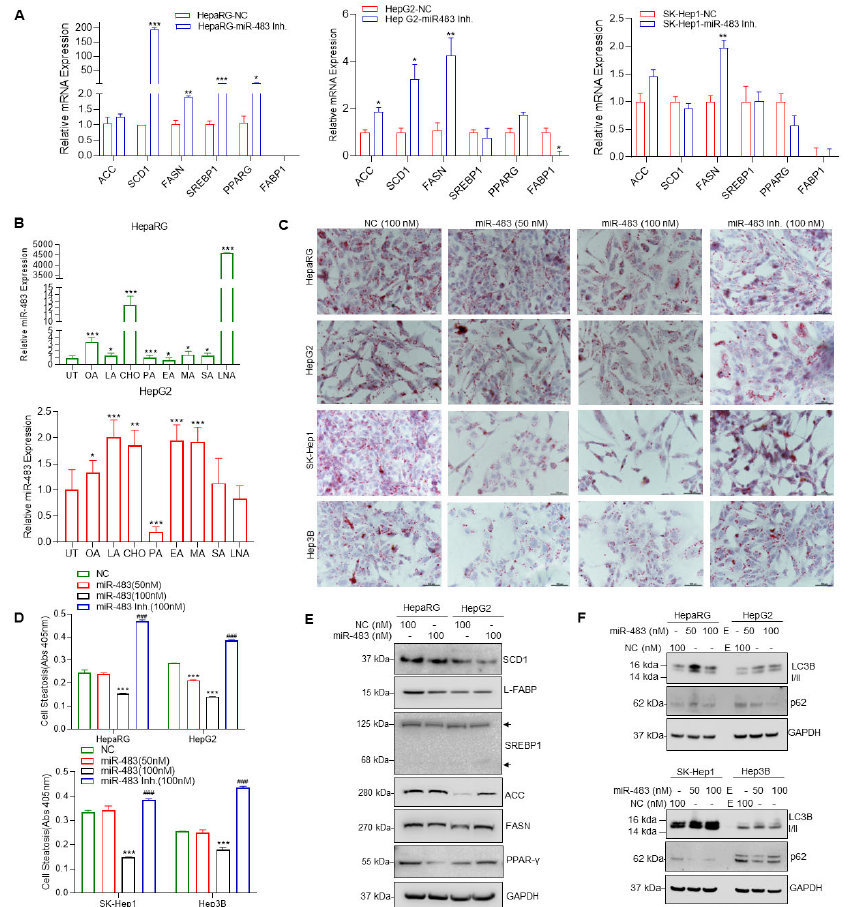
Figure 4. ( A ) HepG2 and SK-Hep1 cells were transfected with NC (100 nM) or miR-483 inhibitor (100 nM) as indicated for 30 h, and the expression of FASN , SREBP1 , ACC , FABP , PPAR γ , and SCD1 were analyzed RT/qPCR. * p < 0.05, ** p < 0.01, *** p < 0.001 compared to NC transfected cells. ( B ) HepaRG and HepG2 cells were treated with 100 µ M of indicated fatty acids for 30 h, and the expression miR-483 was analyzed by RT/qPCR. * p < 0.05, ** p < 0.01, *** p < 0.01 compared with untreated cells (upper and lower panels). ( C ) HepaRG and HCC cells were grown on coverslips and transfected with NC (100 nM) or miR-483 mimic (100 nM) or miR-483 inhibitor as indicated for 18 h and treated with oleic acid (100 µ M) for an additional 24 h. Cells were fixed, stained with Oil Red O (ORO), and images were captured using a Nikon Y-IDP microscope. ( D ) HepaRG and HCC cells were grown in 6-well plates in triplicates, transfected with NC, miR-483, and miR-483 inhibitor for 18 h, and then treated with 100 µ M oleic acid for an additional 24h. Cells were fixed and stained with an Oil Red O (ORO), cells were lysed, and the Oil Red O stain released from steatotic cells was measured by monitoring the absorbance at 405nm using a plate reader. *** p < 0.001, ### p < 0.001 compared with NC-treated cells. ( E ) HepaRG and HepG2 cells were transfected with NC (100 nM) or miR-483 mimic (100 nM)